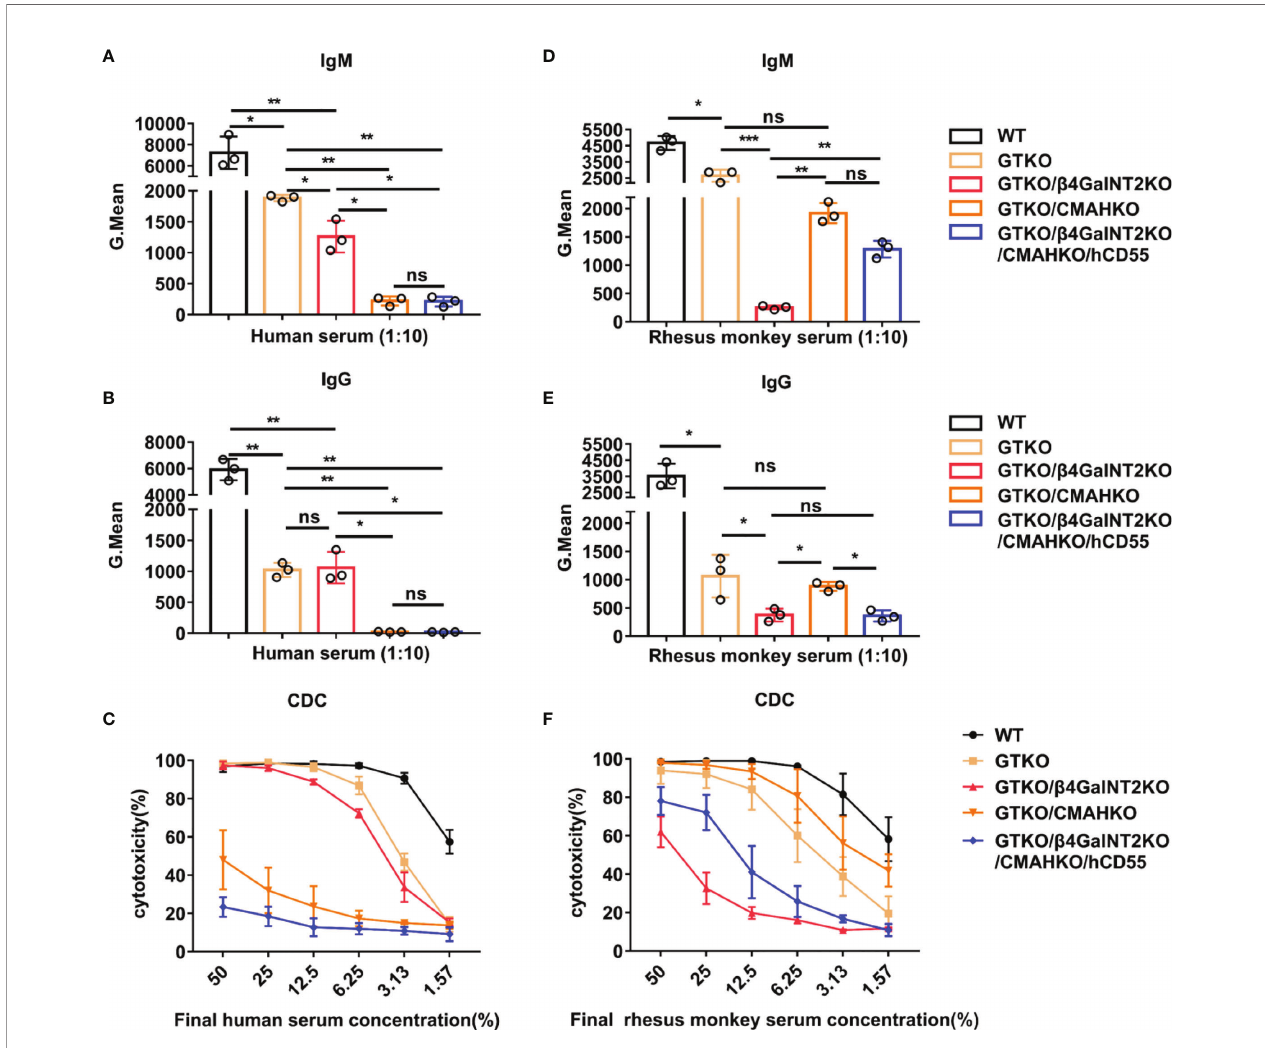
FIGURE 5 | The role of Sda and Neu5Gc expression in the binding of human vs. monkey serum antibody to GTKO pig PBMCs and in CDC against these cells. IgM/IgG antibody binding and CDC were measured by fl ow cytometry after co-culture of pooled human or monkey sera with PMBCs from WT, GTKO, GTKO/ b 4GalNT2KO, GTKO/CMAHKO, or TKO/hCD55 pigs. (A, B, D, E) Pooled human or rhesus monkey serum IgM/IgG binding (at a serum concentration of 10%) to pig PBMCs. (C, F) Pooled human or rhesus monkey serum CDC (at serum concentrations of 50% to 1.57%) against pig PBMCs. Each sample was measured three times. All data are presented as means ± SD (* P <0.05, ** P < 0.01, *** P < 0.001; ns, non-signi fi cant). The P value comes from three independent